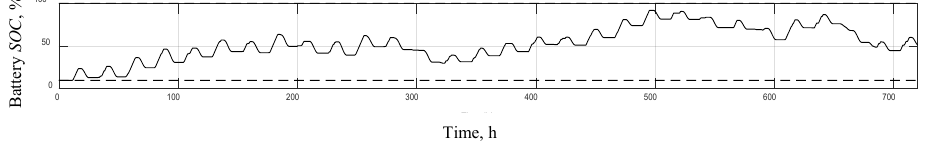
Fig. 5. SOC of 28 MWh BESS over the period of June.